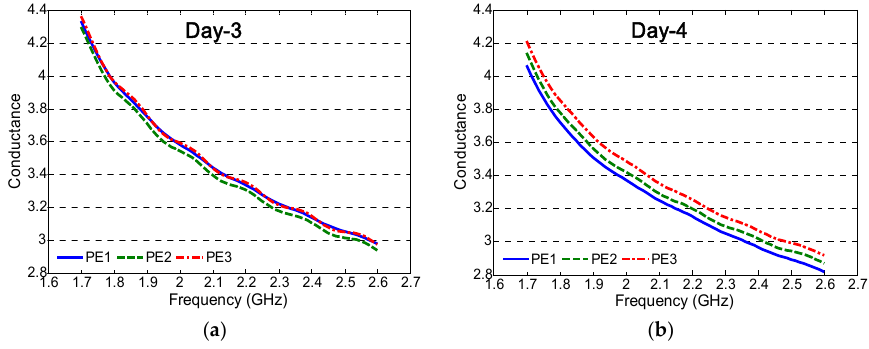
Figure 4. Measured normalized conductance versus frequency: ( a ) on Day-3; ( b ) on Day-4.